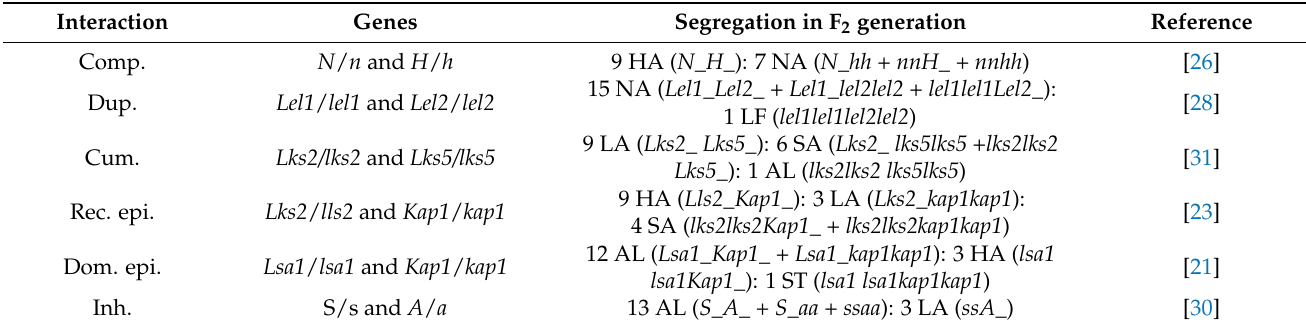
Table 1. Gene interactions for awn development in